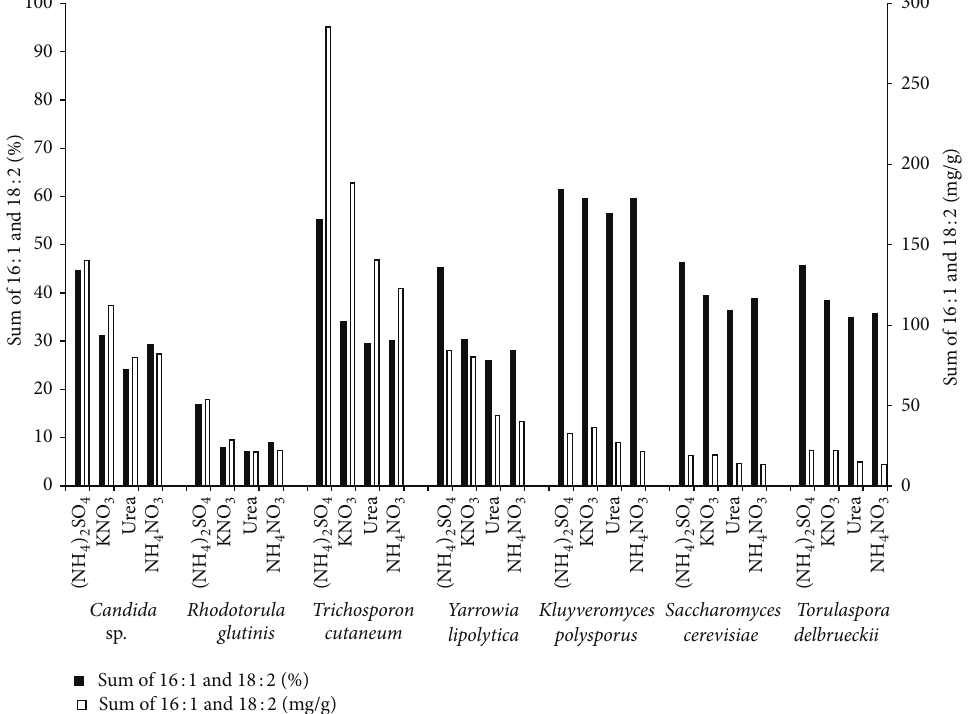
Figure 2: Content of palmitoleic and linoleic acid in total lipids (%, black bars) and the yield of the acids per dry cell weight (mg/g dw, white bars) of the 7 yeast strains cultured on 4 nitrogen sources at C/N ratio